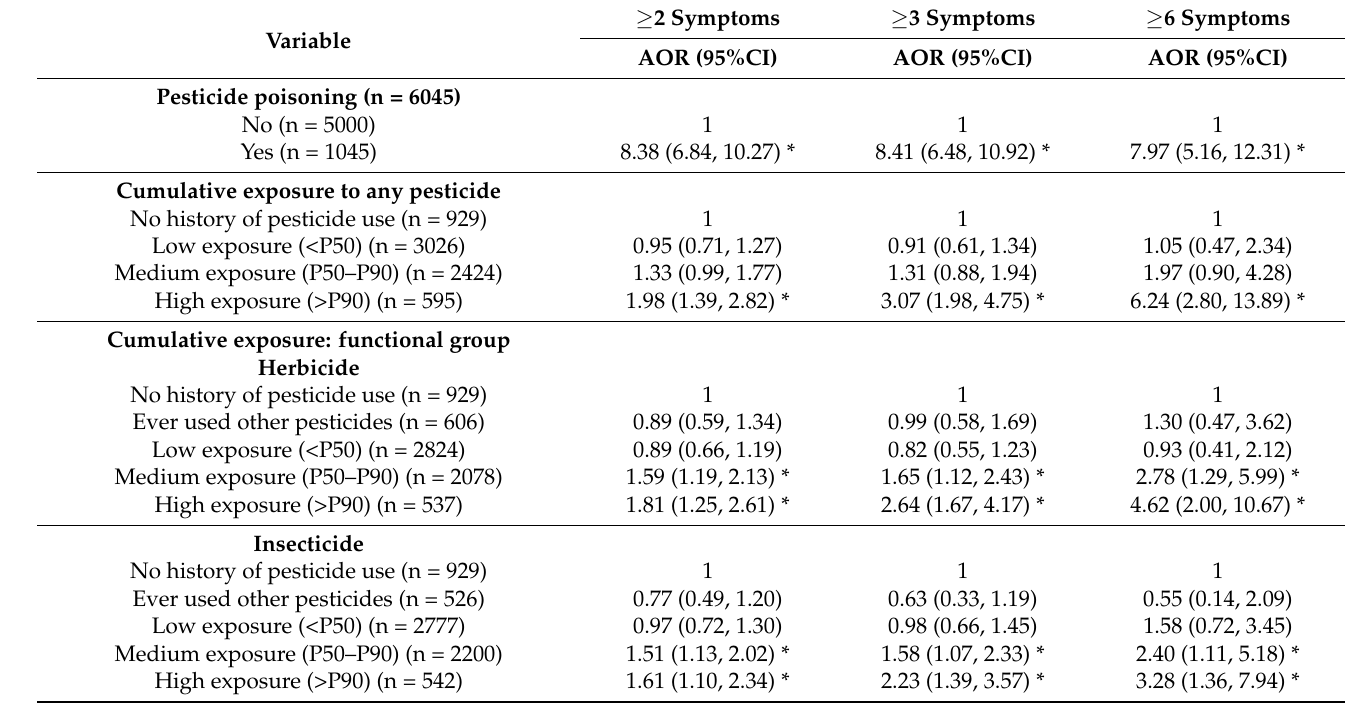
Table 4. Adjusted odds ratios of neurotic symptoms and probable mental disorder from occupational exposure to pesticides in Thai farmers (n =